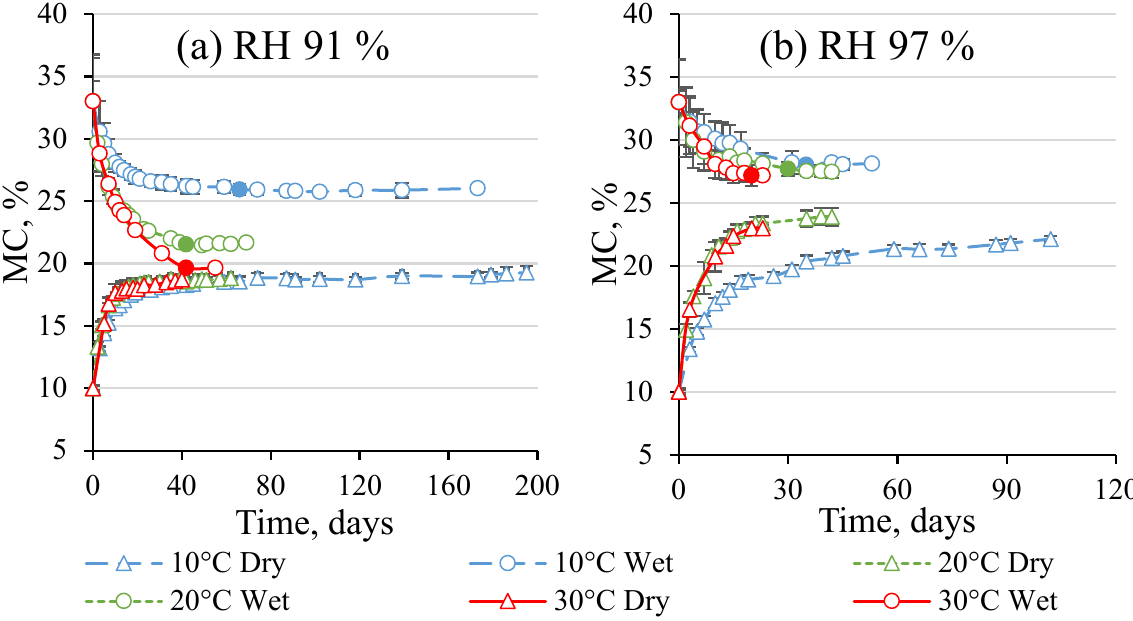
Figure 3. Changes in moisture content (MC) of ‘Dry’ and ‘Wet’ specimens exposed to constant conditions: temperature (10, 20 and 30 °C) and humidity ( a ) RH 91% and ( b ) RH 97%.